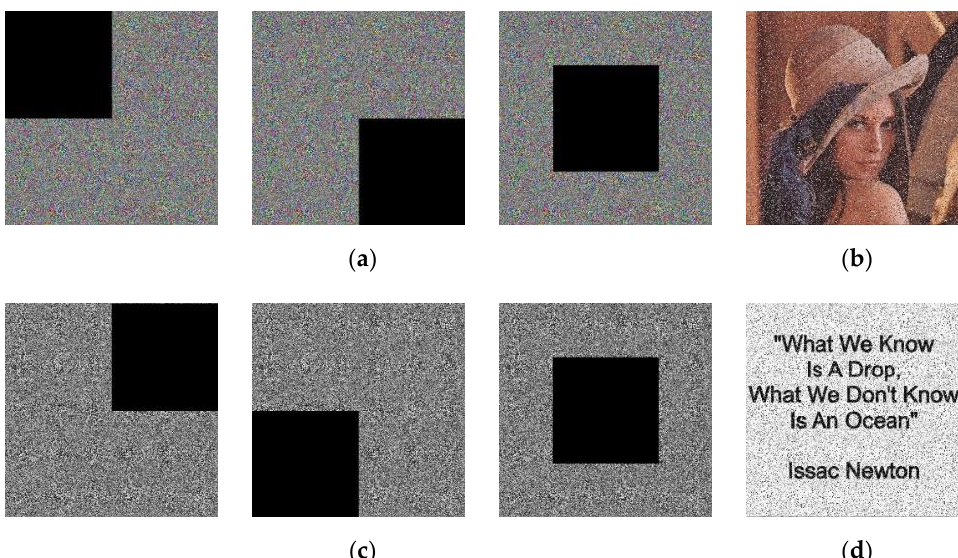
Figure 8. ( a ) Lena_encrypted.jpeg with 25% occlusion in different zones, ( b ) Decryption of Lena_encrypted.jpeg. after 25% occlusion attack, ( c ) Message_encrypted.jpeg with 25% occlusion in different zones, ( d ) Decryption of Message_encrypted.jpeg after 25% occlusion attack.